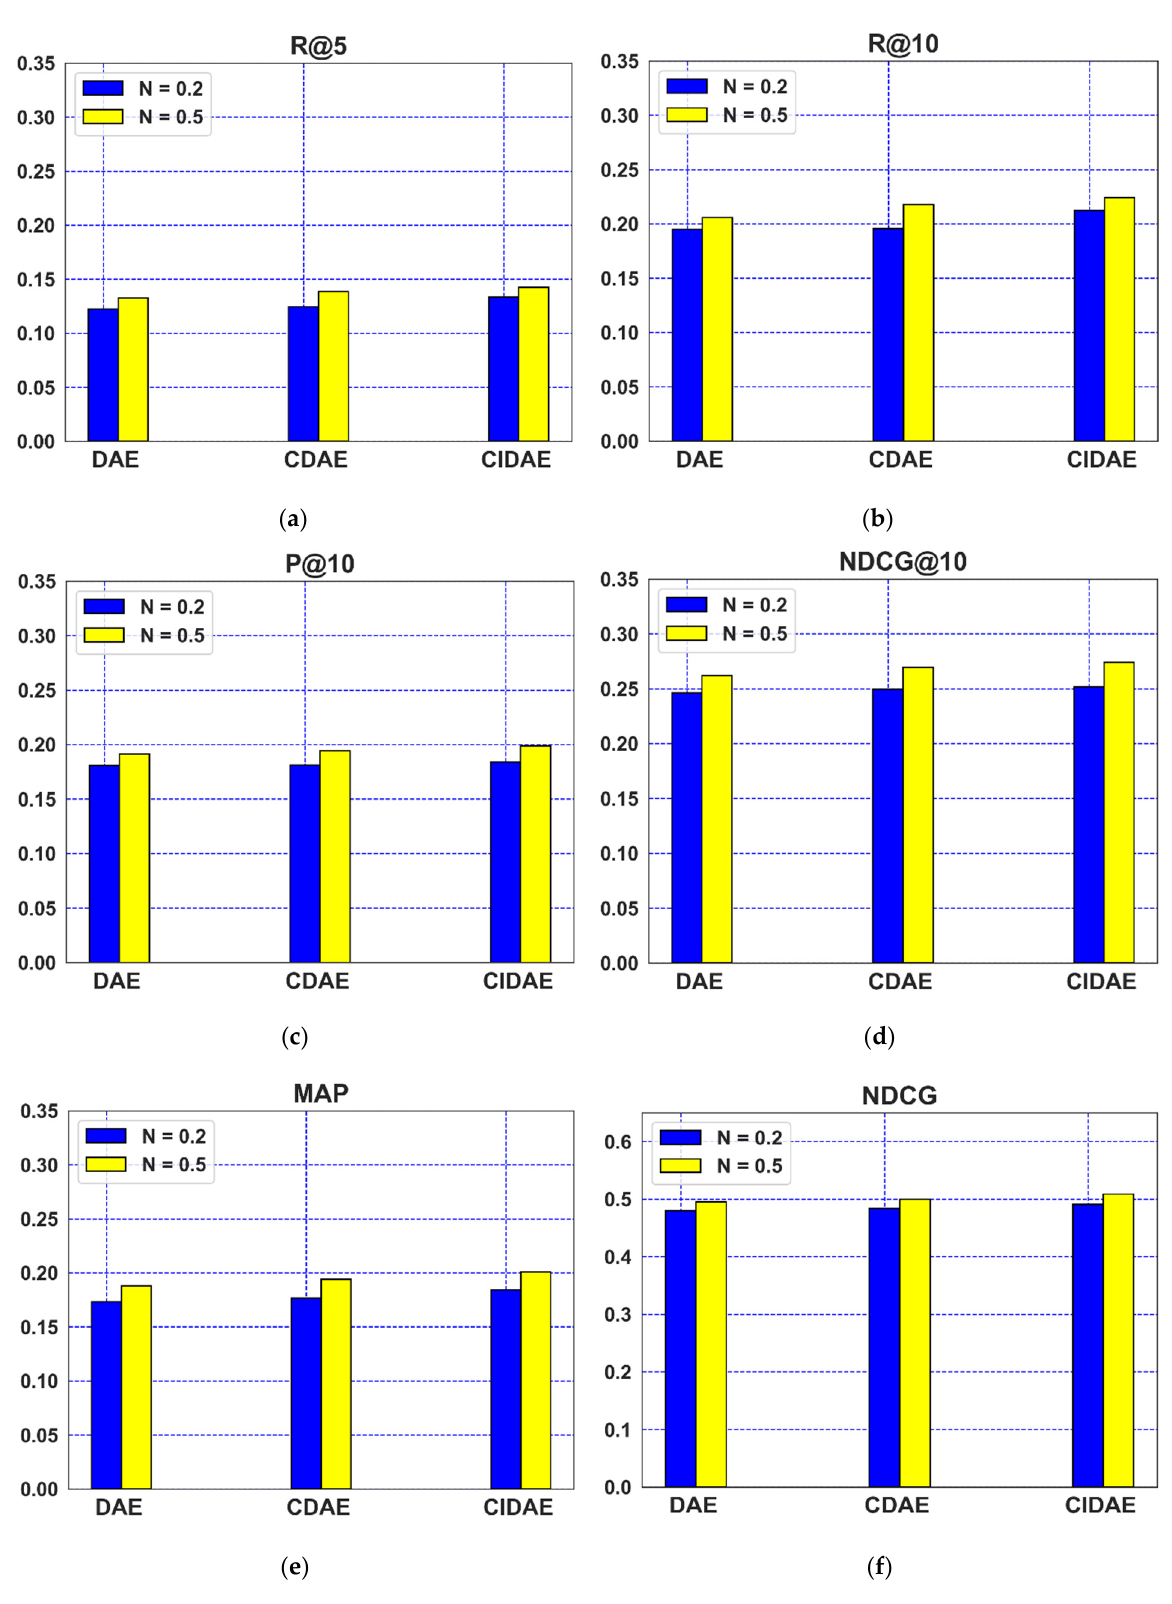
Figure 9. Comparison through R@5, R@10, P@10, NDCG@10, MAP, and NDCG metrics for ML ‐ 100K.